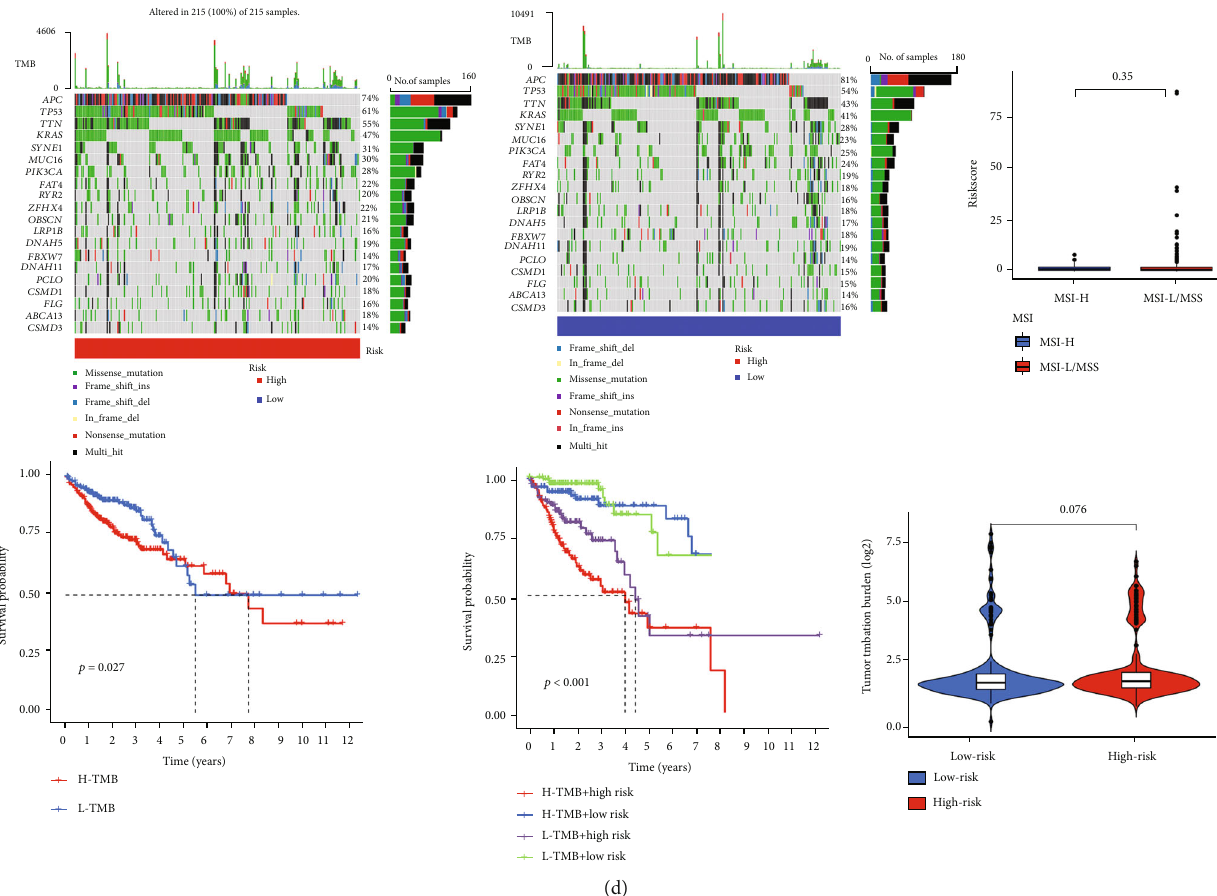
Figure 8: Response to immunotherapy and evaluation of microsatellite instability and tumor mutation burden among high- and low-risk groups. (a) The association between IPS and risk groups for CRC patients. (b) The chemotherapy prediction of risk groups through IC50 of drugs. (c) Distribution of MSS, MSI-L, and MSI-H patients between high- and low-risk groups, and comparison of risk scores in MSI-H and MSS/MSI-L groups. (d) Mutation pro fi les of high- and low-risk groups, survival analysis associated with TMB and risk groups, and di ff erences of TMB between high- and low-risk